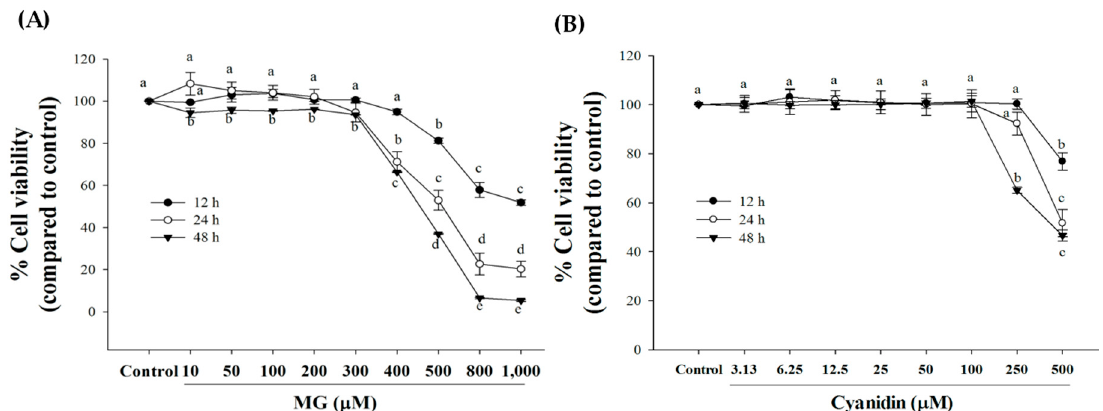
Figure 1. Effect of cyanidin and methylglyoxal (MG) on cell viability during 12–48 h. ( A ) Treatment of cells with MG 500–1000 µM decreased cell viability during a 12–48 h period. ( B ) 100 µM or lower concentrations had no effect on cell viability during a 12–48 h period. Results are presented as mean ± SEM ( n = 3). The groups that do not share a common letter are significantly different ( p < 0.05).